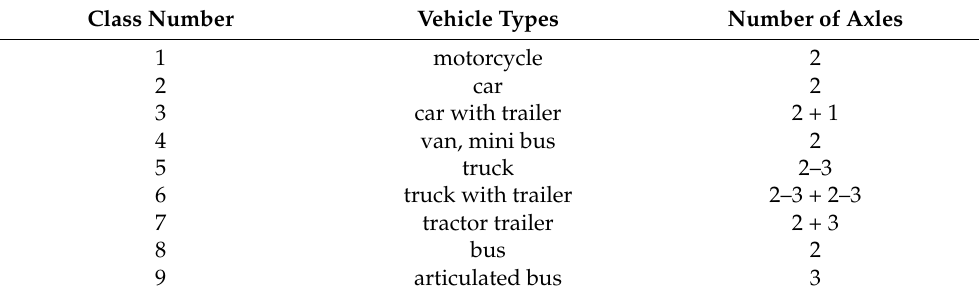
Table 4. Used vehicle